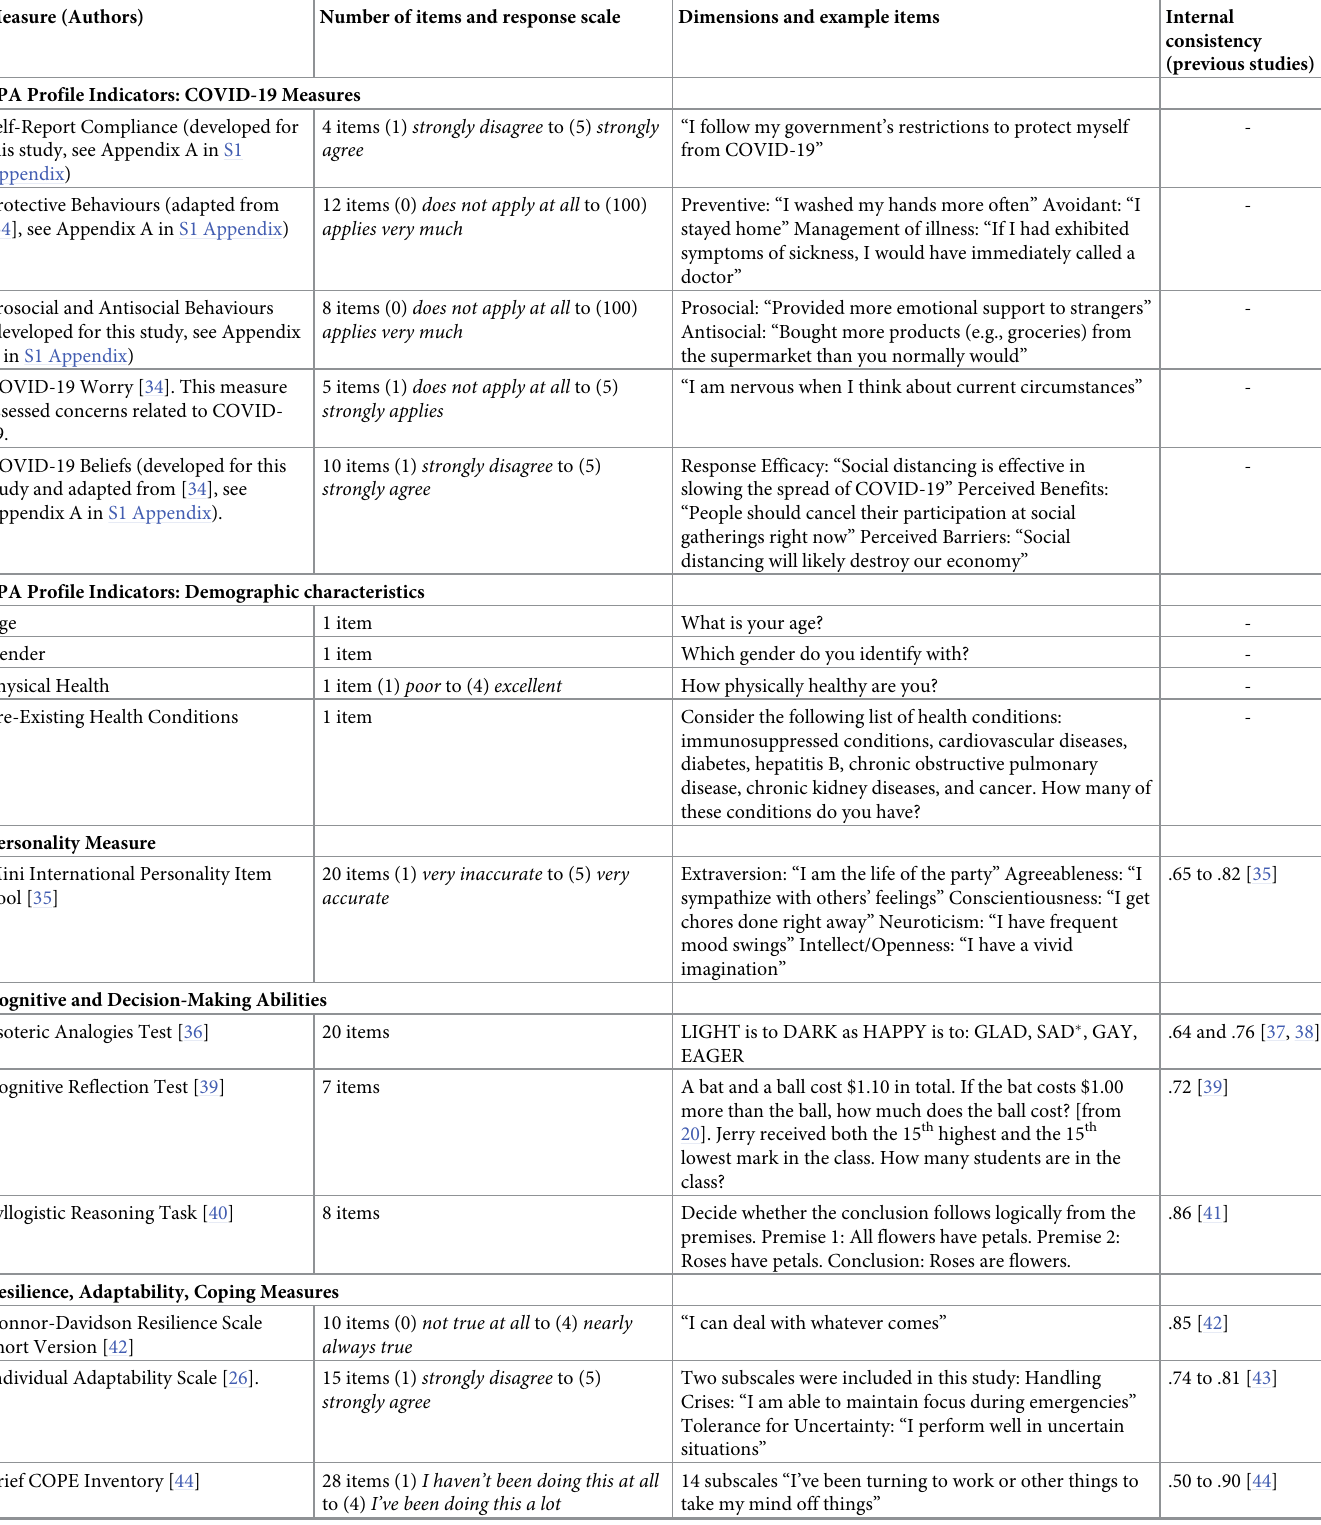
Table 1. Measures employed in this